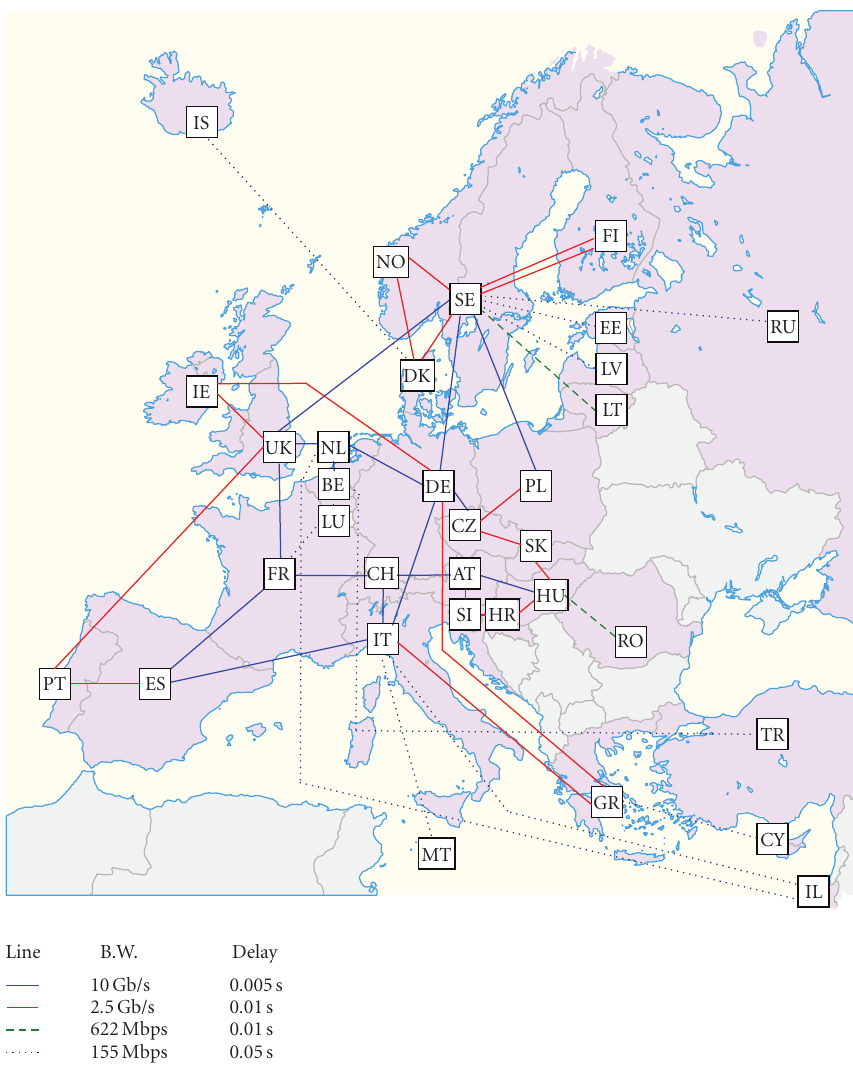
Figure 4: G´EANT network